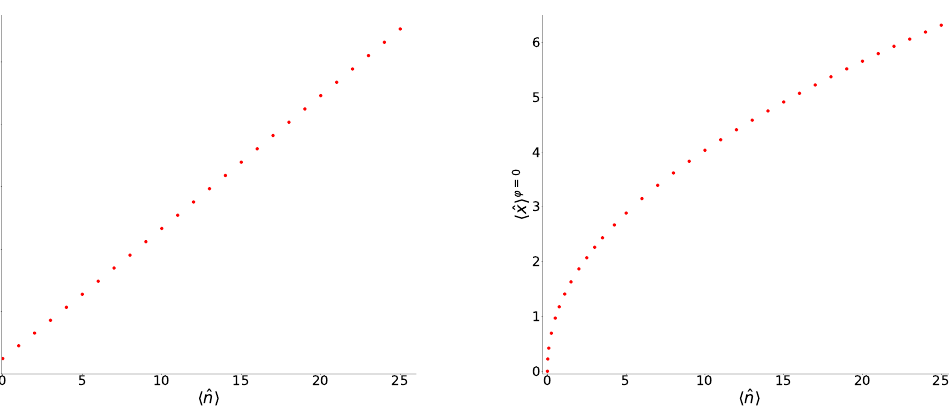
= 0 (cid:104) ˆ n (cid:105) in the coherent Figure 4. Left: the coordinate variance σ ϕ x versus the mean number of quanta phase state (2) (numeric results). Right: The mean value (cid:104) x (cid:105) ϕ = 0 in the coherent phase state (2) (numeric results). All numeric results were obtained taking into account 10,000 terms in series S 1 and S 2